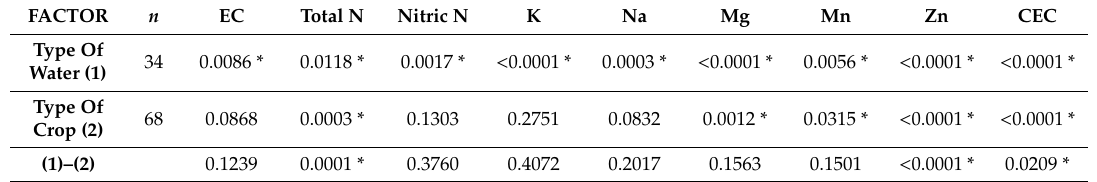
Table7. p -valuesfortypeofwater(1),